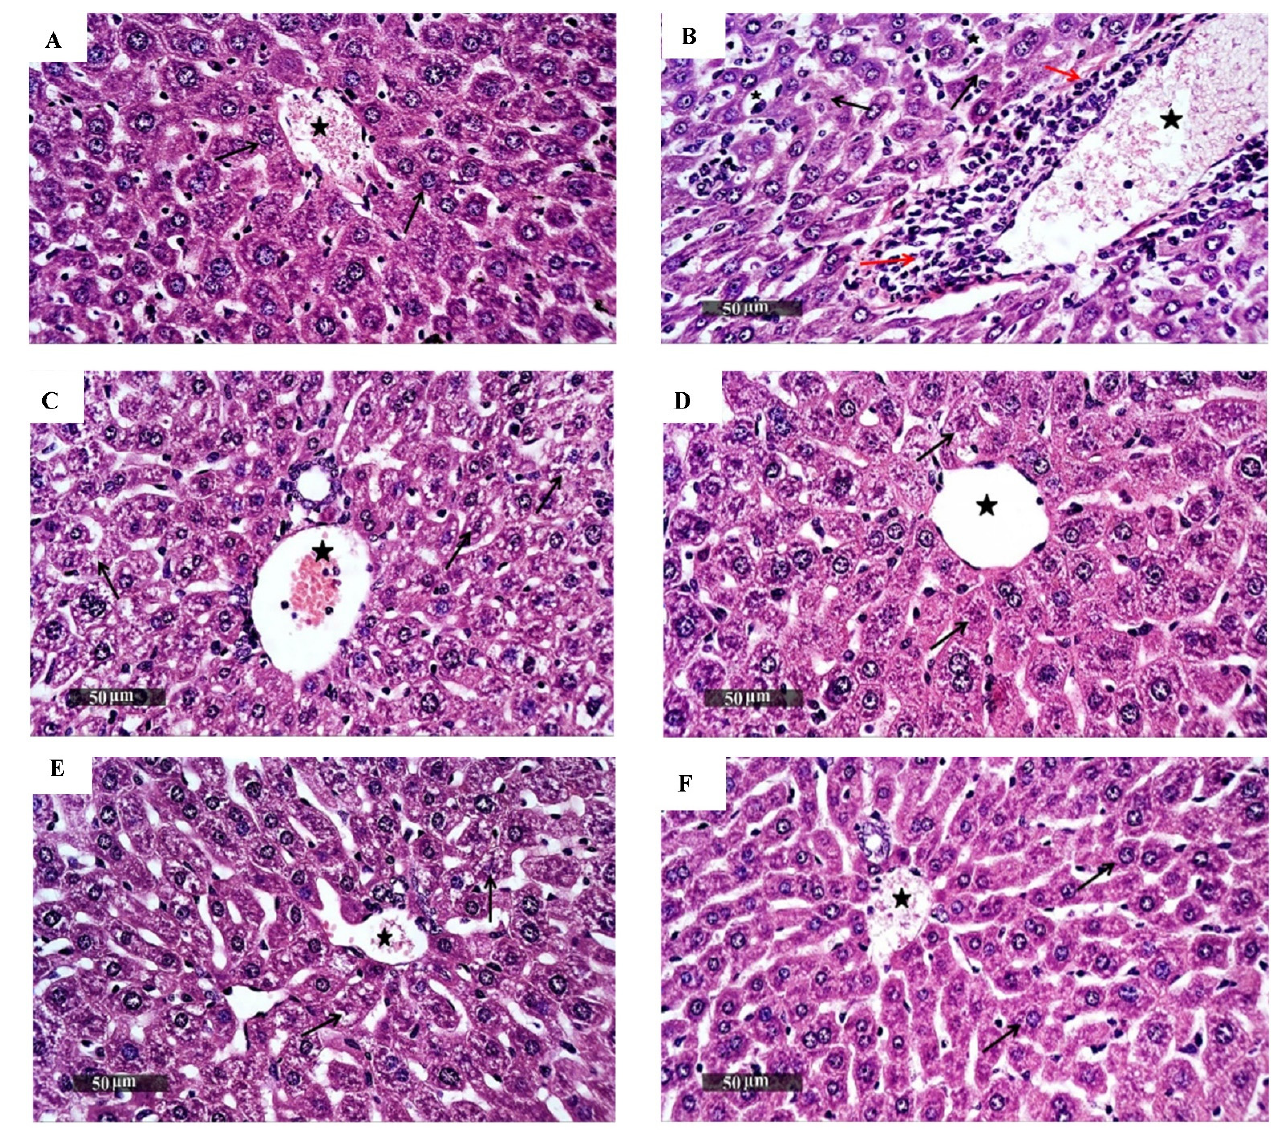
Figure 2. Photomicrographs of mice liver sections stained by H and E from ( A ) the normal control group, which demonstrated normal histological features of the liver parenchyma with apparently intact well-organized hepatocytes with intact subcellular details (black arrow), normal hepatic sinusoids, vasculatures (star), and portal tracts; ( B ) Dox-treated mice as the positive control group, which showed hepatocellular necrotic changes (arrow) accompanied with moderate dilatation of the hepatic blood vessels and hepatic sinusoids (star) associated with focal perivascular mixed inflammatory cell infiltrates (red arrow); ( C ) mice treated with compound 3a, which showed intact vasculatures (star) as well as hepatic sinusoids with no inflammatory cell infiltrates; ( D ) mice group treated with compound 4b, which demonstrated apparently intact hepatocytes and allover hepatic parenchyma with intact vasculatures (star), and almost no record of inflammatory cell infiltrates; ( E ) mice treated with compound 4c, and ( F ) negative control group that received DMSO. Both ( E , F ) groups showed almost intact histological features of hepatic parenchyma (as normal control; ( A )). [scale bars 50 μ m].